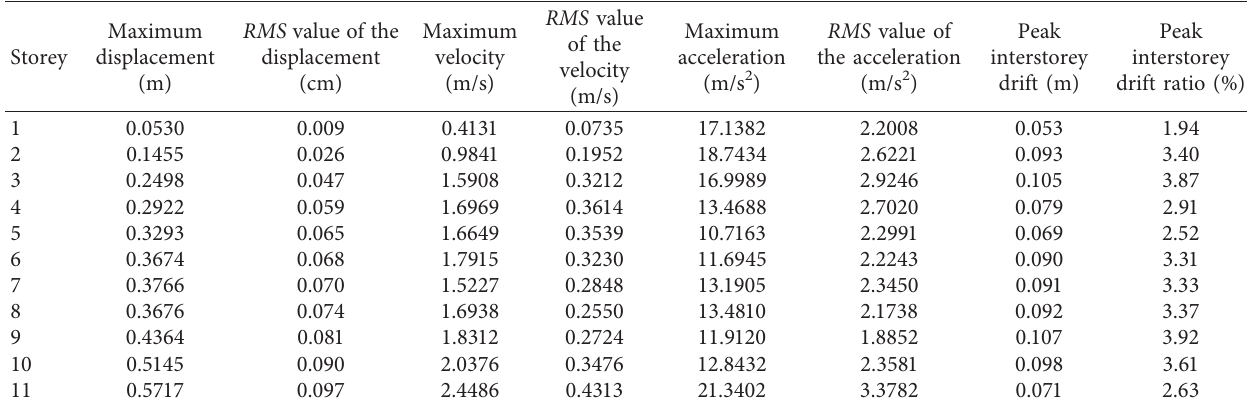
Table 5: Response of the uncontrolled structure when it is excited by “ Kobe ”